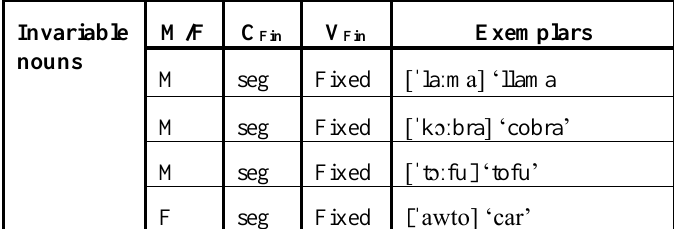
Table 10. Roots with final vowel lexically fixed (invariable